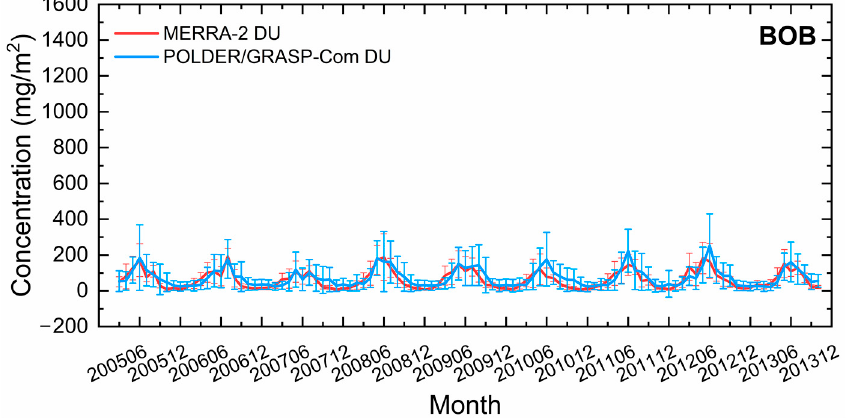
Figure 12. Same as Figure 3, but for Bay of Bengal (BOB) region.